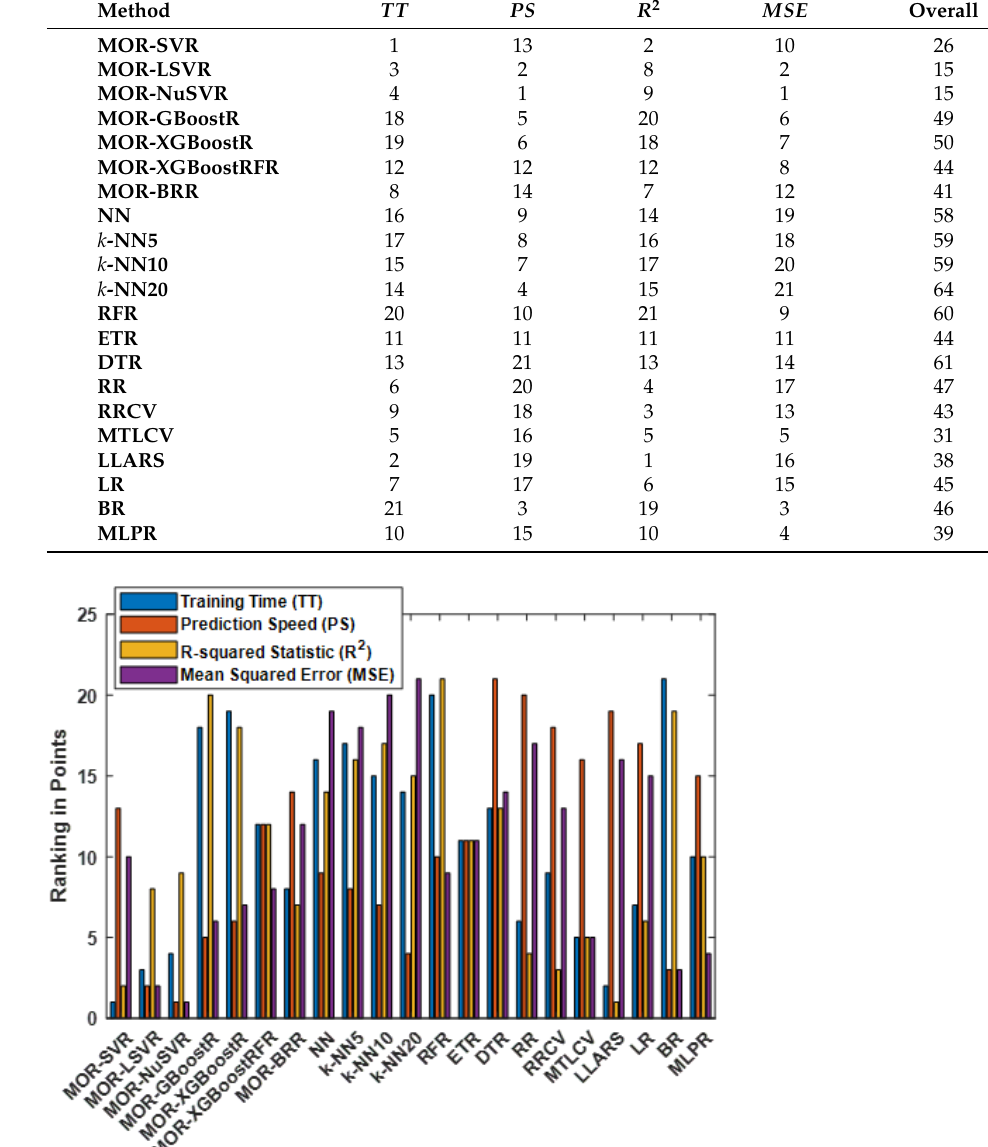
Figure 12. Ranking (in points) of all methods using the average values of their performance metrics (i.e., TT , PS , R 2 , and MSE ) over 50 statistical runs for the second